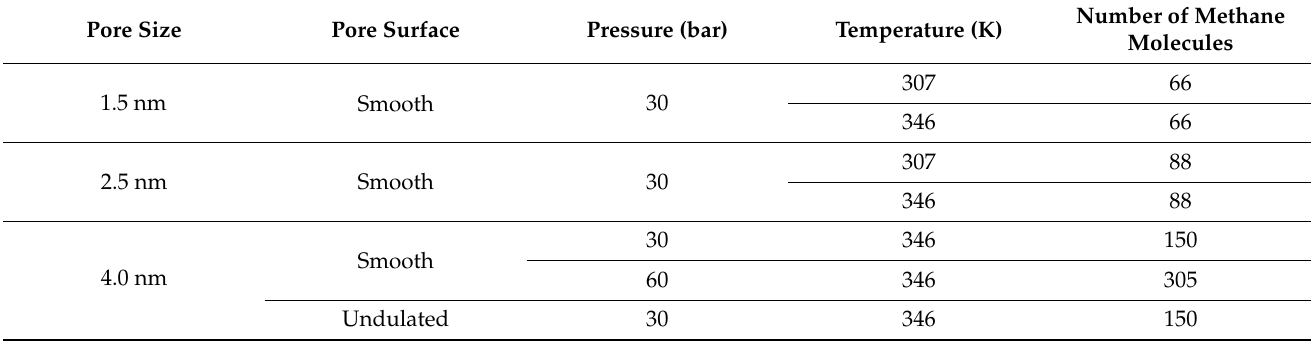
Figure 1. Simulation snapshots from the MD simulations of methane loaded in different pores at 323 K and 30 bar. The top two panels show the smaller pores of size 1.5 nm and 2.5 nm, while the bottom panels show the 4 nm pore with undulated and smooth pore profiles as indicated. Blue, red, white, and brown spheres represent silicon, oxygen, hydrogen atoms, and methane molecules in the united atom formalism. Table 1. The number of methane molecules adsorbed in the amorphous silica pores at different temperature and pressure conditions. MD simulations were carried out on all the environmental conditions listed in the table.